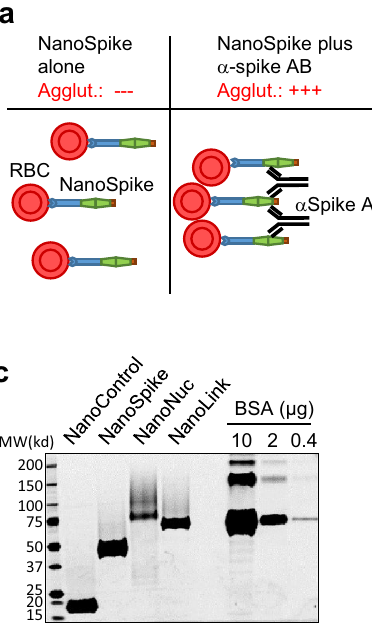
Figure 1. Recombinant proteins and test principle. ( a ) Principle of NanoSpike-mediated hemagglutination in the presence of αSpike AB. ( b ) Schematic presentation of recombinant proteins. S, secretion signal (IFNβ); αGPA-nano, GPA-specific nanobody; L, flexible linker; Spike, Spike-RBD of SARS-CoV-2; S-tag, Tandem-Strep- tag; 2xαSpike-Nano, tandem-fusion construct of two Spike-RBD-binding H11-D4 nanobodies, separated by flexible linker; Hinge-IgG1-FC, dimerizing Hinge-FC moiety of IgG1. ( c ) SyproRuby-stained SDS PAGE of 3 µg of indicated proteins that were expressed in Expi293F cells and purified by one-step affinity purification. Protein yield from 25 ml of Expi293F-cell cultures were 2 mg (NanoControl), 3.75 mg (NanoSpike), 0.55 mg (NanoNuc) and 1.25 mg (NanoLink). Defined amounts of BSA are shown for